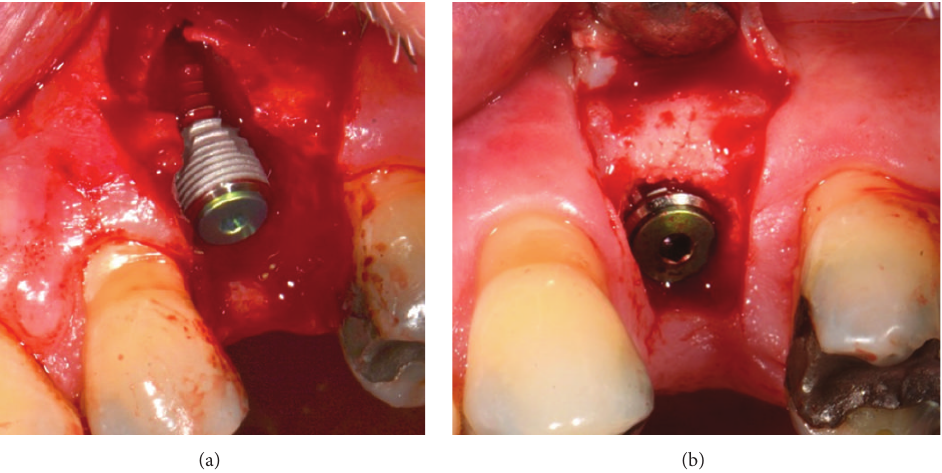
Figure 5: Case 3: a 62-year-old male with root fracture in the maxillary left second premolar. (a) Implant placed at the optimum 3D positioning with low initial stability, leaving a buccal dehiscence. (b) Reentry after 10 weeks showing excellent bone regeneration of the site. ISQ reading was